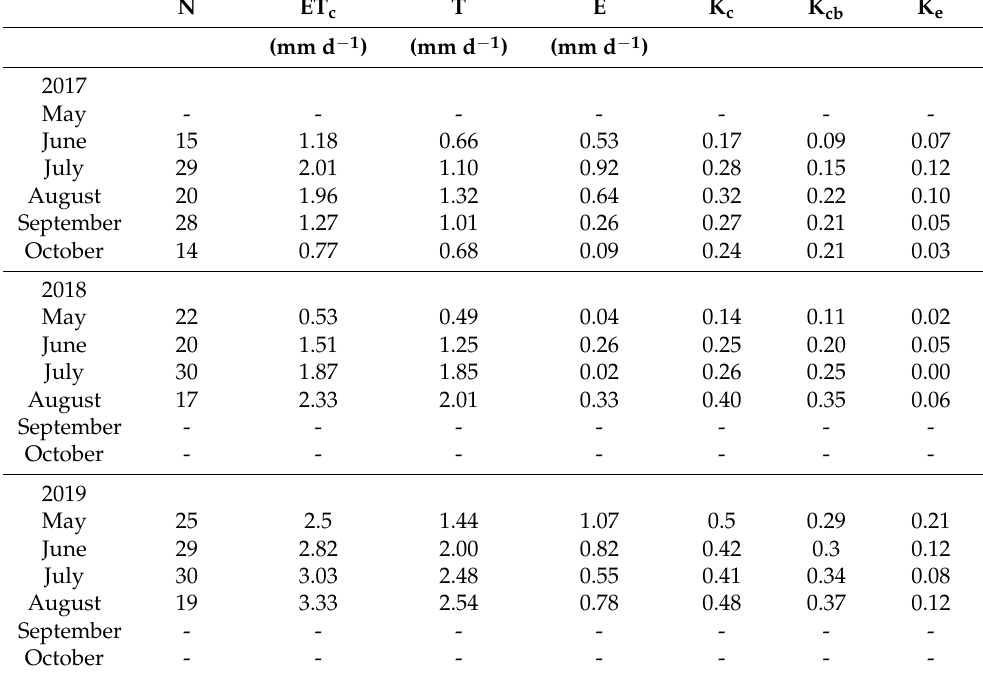
Table 5. Monthly mean values of crop evapotranspiration (ET c ), canopy tree transpiration (T), soil evaporation (E), and crop coefficients (K c , K cb , and K e ) for the 3 almond growing seasons of the experiment. The number of days (values) used per month (N) is also